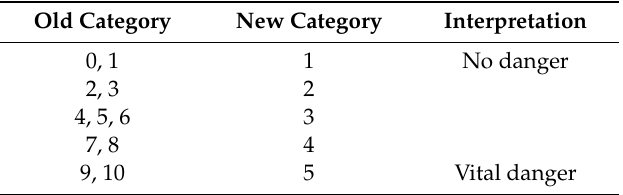
Source: Own results.